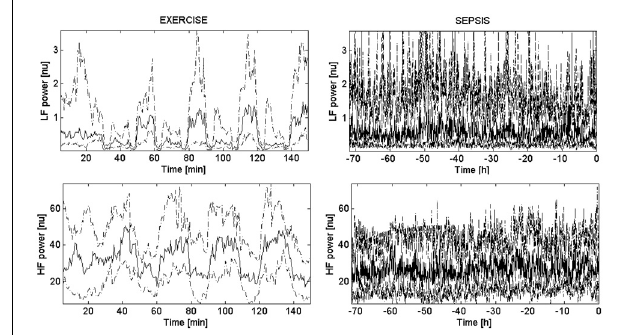
FIGURE A1 | Population trends of LF and HF power. Body: These four panels show the population trends of LF (top) and HF (bottom) power computed through the Lomb–Scargle periodogram. Each panel depicts the median trend across all the subjects (bold solid line) and its 95% confidence intervals (dashed line) for the EXERCISE dataset (left) and the SEPSIS dataset